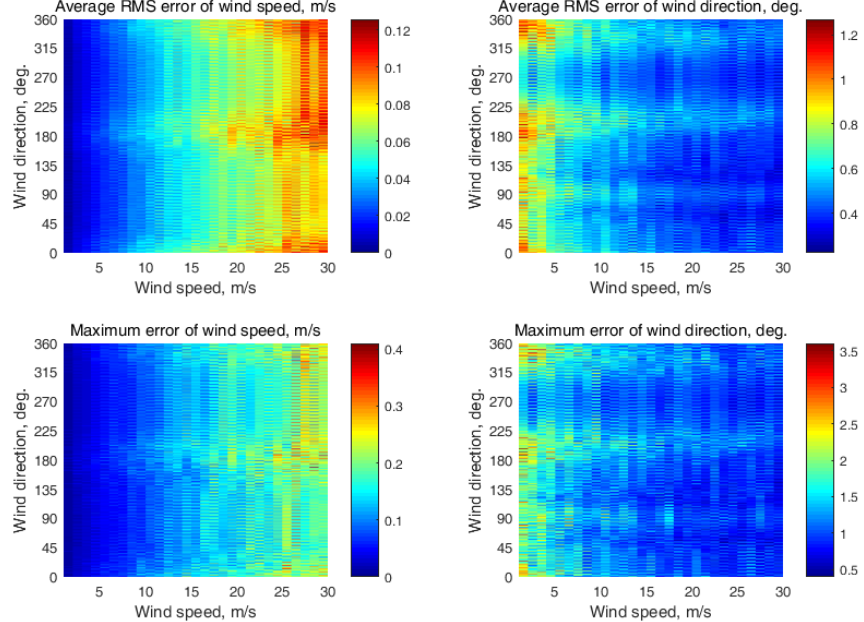
Figure A23. Semicircular wind retrieval results at the (45°, 50°, 55°, 60°) incidence angle combina- tion.